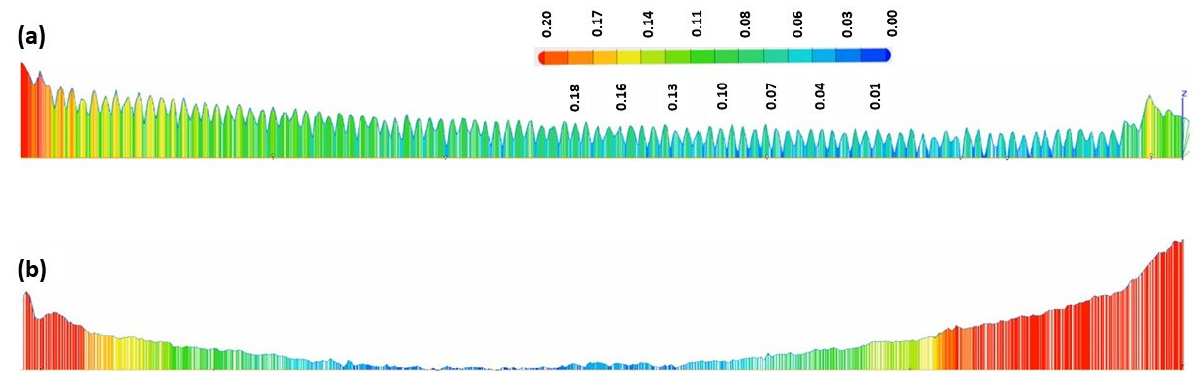
Figure 14. In-plane section view of S3; ( a ) before and ( b ) after laser polishing. Figure 14. In ‐ plane section view of S3; ( a ) before and ( b ) after laser polishing.